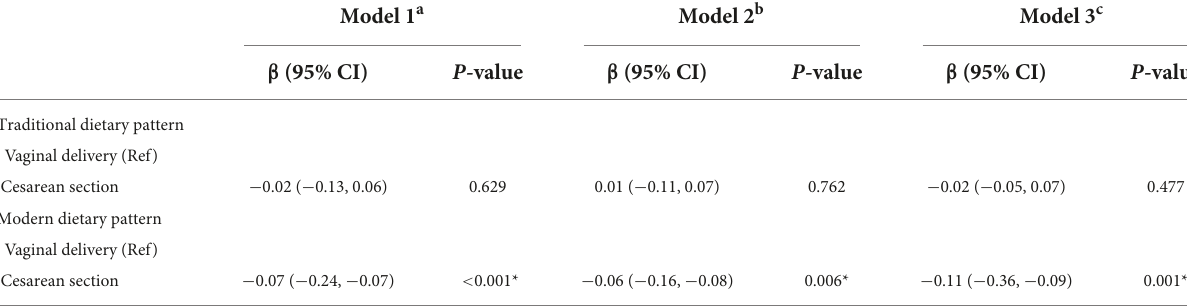
TABLE 3 Associations between modes of delivery and postpartum dietary intake.